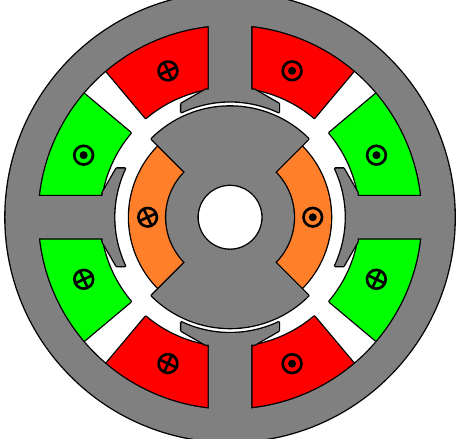
Figure 10. Short pitch winding slotted resolver with four